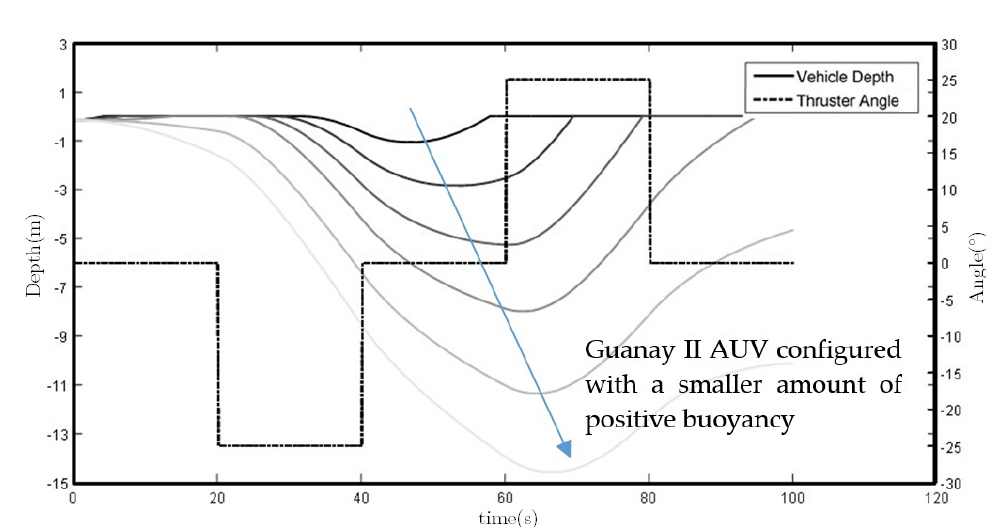
Figure 22. The vehicle’s vertical plane trajectory simulation with different buoyancy configurations, using the lateral thrusters at + 25 and − 25 degrees of inclination. This simulation shows that if the vehicle has a low buoyancy, the thrusters may not have enough force to bring the vehicle back to the surface. Therefore, careful buoyancy adjustment is mandatory before each mission.